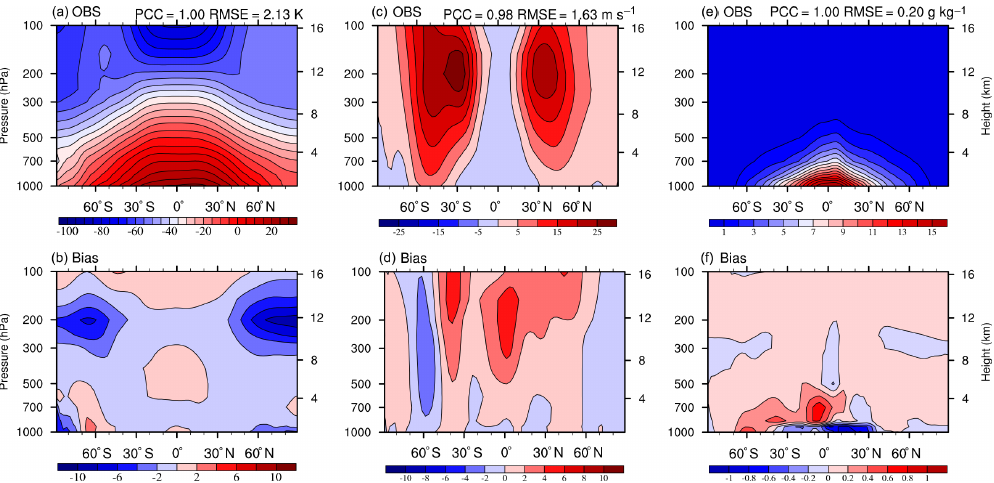
Figure 10. The zonal and climatological mean of temperature ( a, b ; K), zonal wind ( c, d ; ms − 1 ), and specific humidity ( e, f ; gkg − 1 ) in observations (a, c, e) and model bias (b, d, f) . The observational data were derived from ERA-Interim